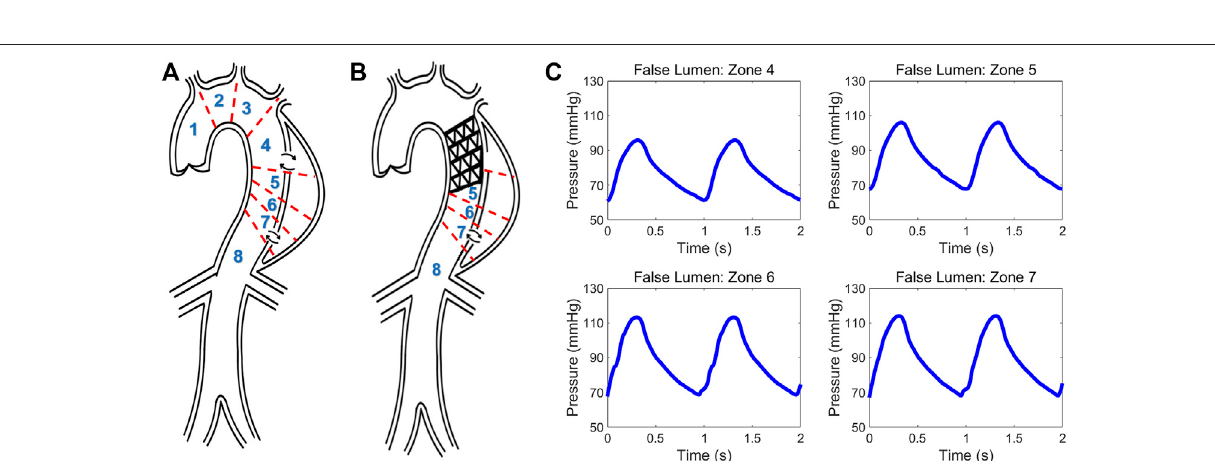
Figure 6A . The expected fi ducial features of the pressure wave inside the TL including the pressure dicrotic notch can be seen in this Figure. The shape of the FL pressure waveform matches well with the measured data shown in Figure 5C . Figure 6B demonstrates the computed fl ow waveform inside the FL at